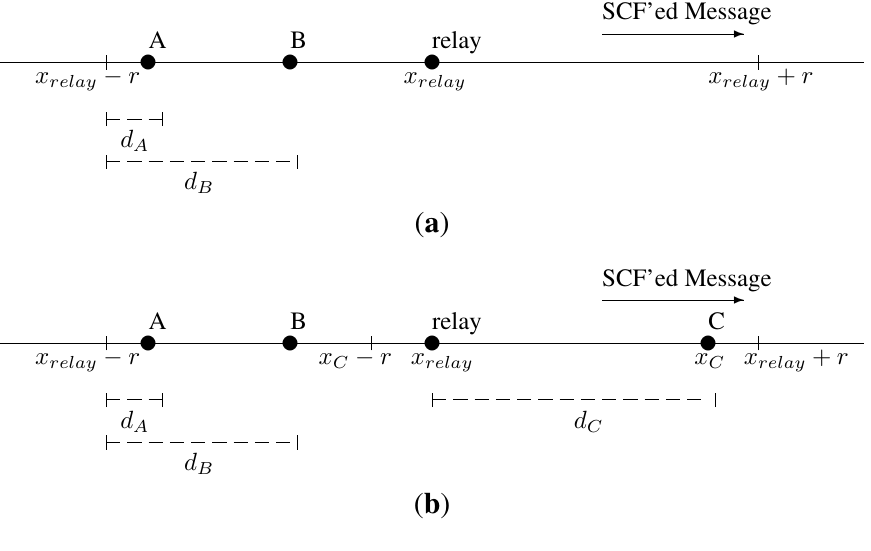
− r, x + r ] . ( a ) Equation (9) lets us select B relay relay